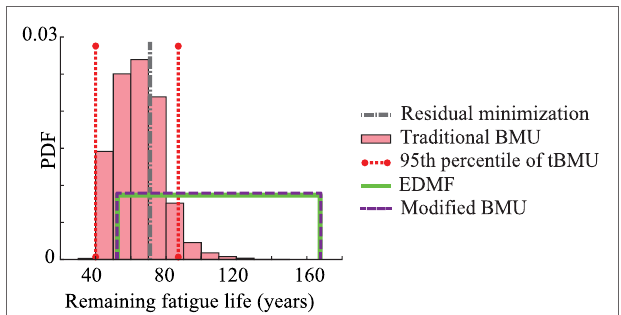
FIGURE 9 | Computation time for identification using four combinations of the probabilistic data-interpretation methodologies. The hardware used for computation is described in Section